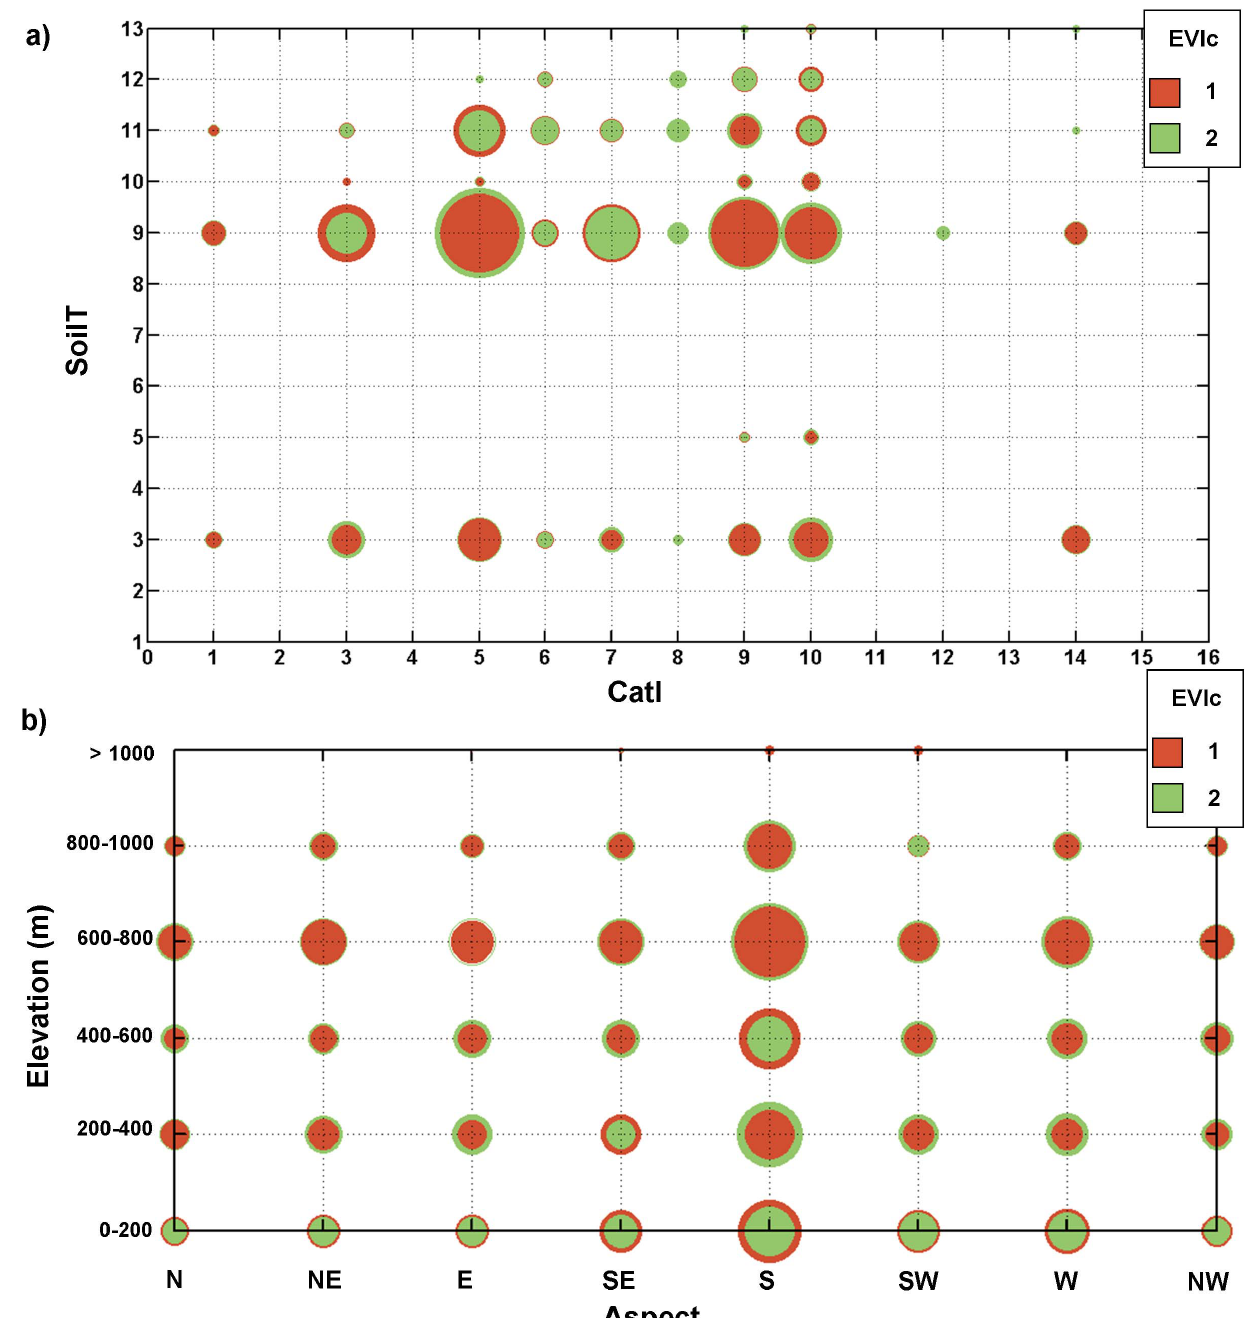
Figure 3. Climate, soil and vegetative growth in Iberia. a) CatI over Iberia calculated according to Table 1, for the period of 1989-2012 using WRF simulations. b) SoilT according to Table 2 using HWSD data. c) Mean EVI and EVIc for the grapevine growth period (April-October) in 2012, using MODIS data. The spatial-average of the vineyard areas corresponds to 0.23. Below this value the EVIc equals 1 (transparent overlay), above this value EVIc equals 2 (hatched overlay).